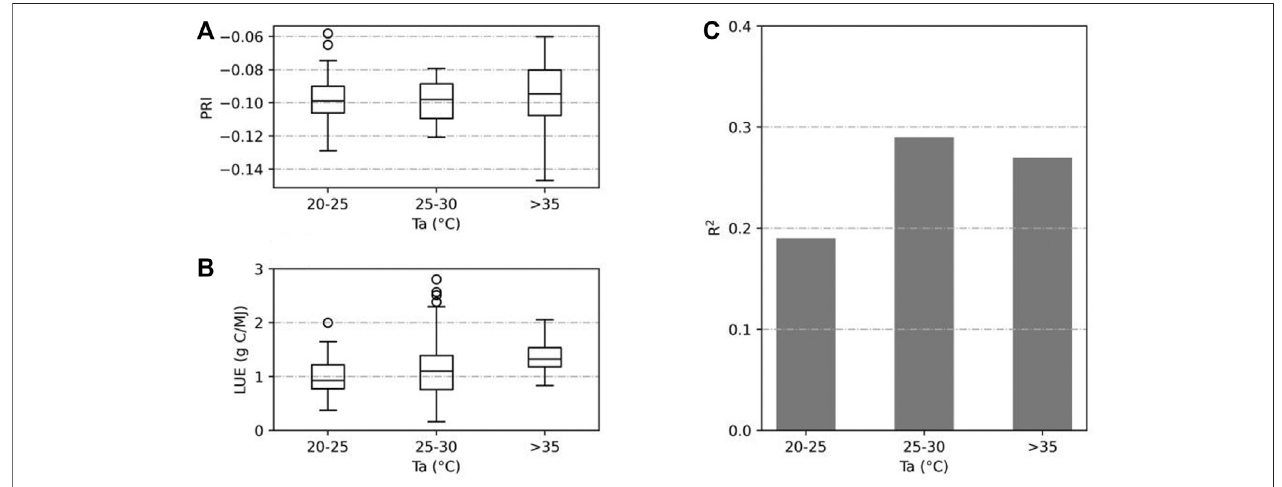
FIGURE 10 | Half-hour time scale of PRI and LUE are as affected by Ta (A , B) . Correlation between PRI and LUE under different Ta gradings (C) .